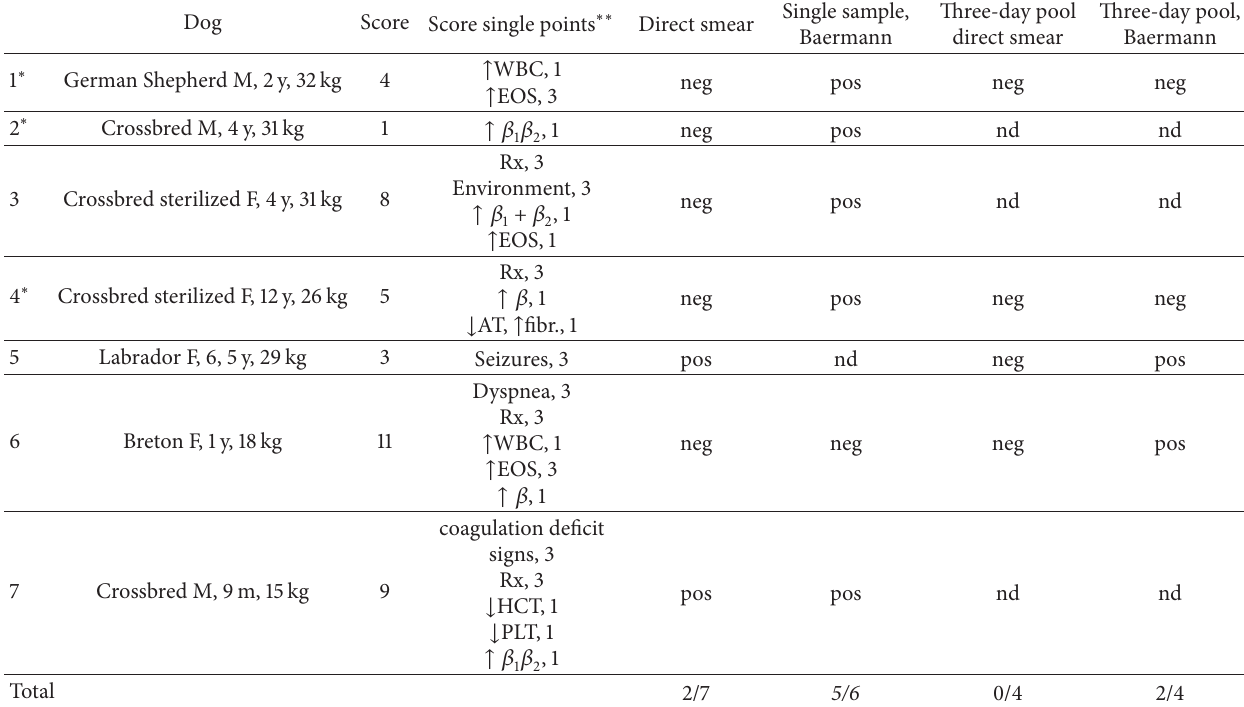
Table 2: Breed, sex (M: male, F: female), age (y: years, m: months), clinical pathological score, and results of diagnostic tests (neg: negative, pos: positive, and nd: not determined) of 7 dogs resulting positive to Angiostrongylus vasorum